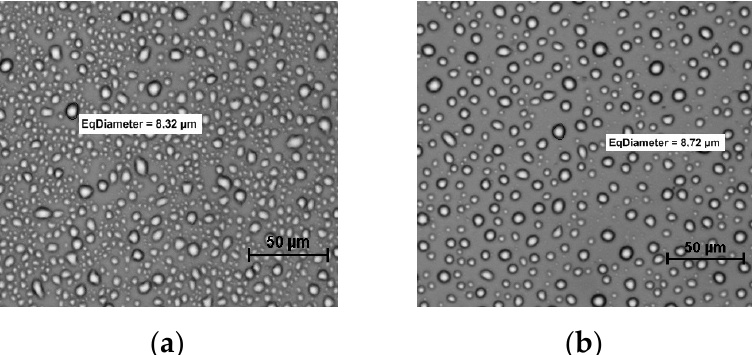
Figure 4. Microscopic images of ice crystals in model sucrose solutions with the addition of enzymatic hydrolysates of κ-carrageenan (after HCL hydrolysis), after 24 h ( a ), and 96 h ( b ) of storage at −8 °C (Kamińska-Dwórznicka et al., 2016 [5]).